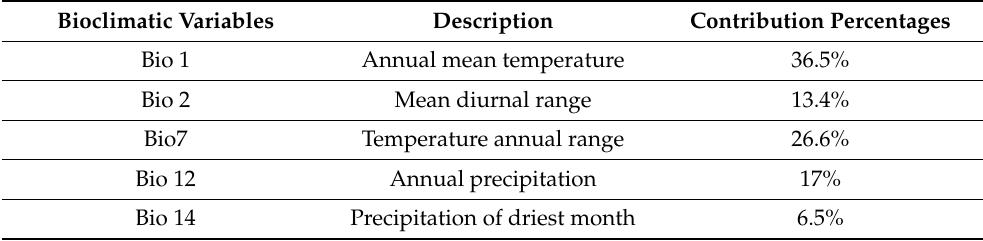
Table 1 . Relative percentages of bioclimatic variables used in Maxent to model the current and fu- ture habitat suitability of.